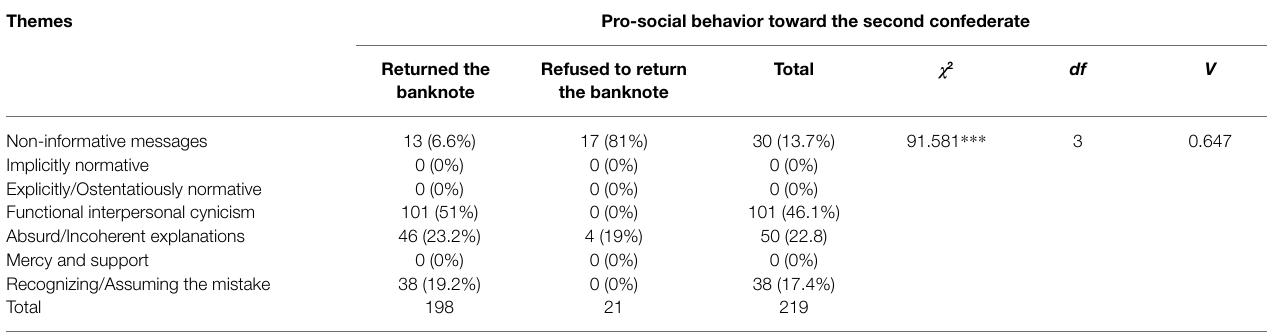
TABLE 6 | Cross-tabulation of pro-social behavior toward the second confederate and the themes generated during the post-experimental interview ( N = 219). Themes